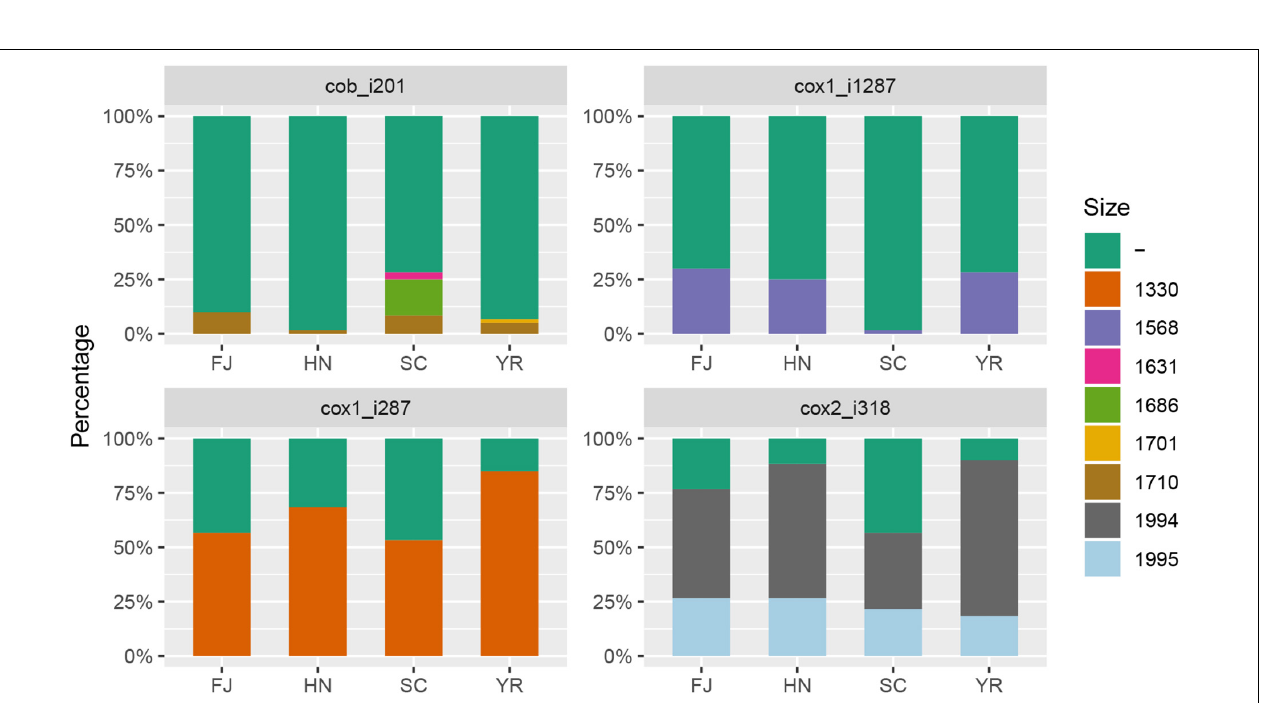
Frontiers in Microbiology |